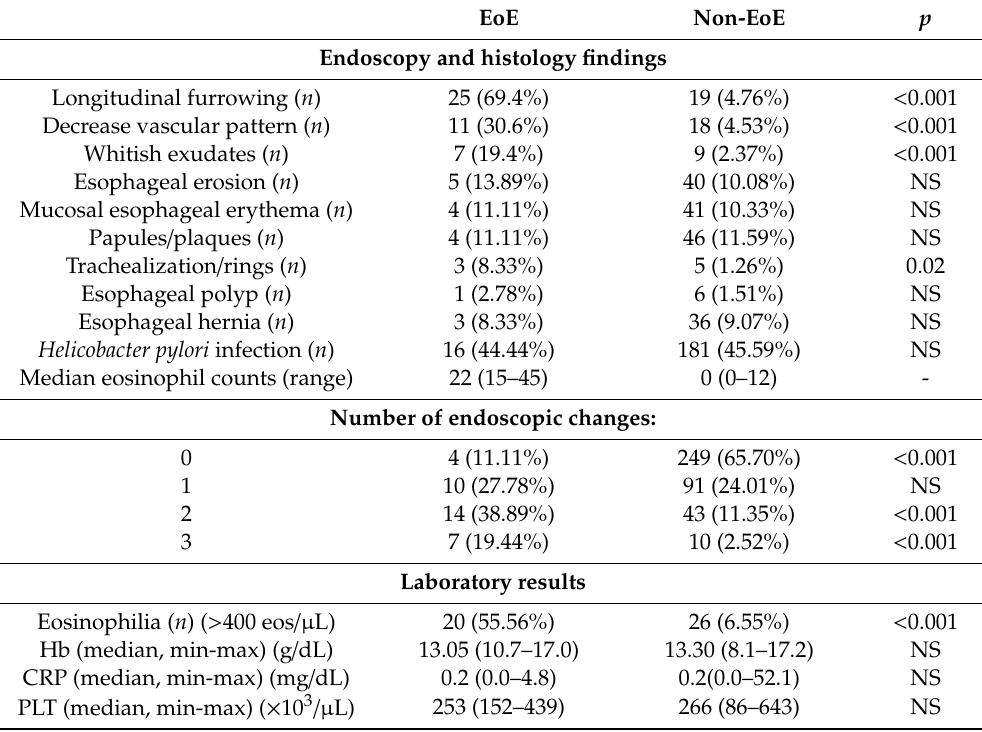
Table 2. Endoscopy findings, histology and laboratory results in EoE and non-EoE groups. EoE Non-EoE p Endoscopy and histology findings Longitudinal furrowing ( n